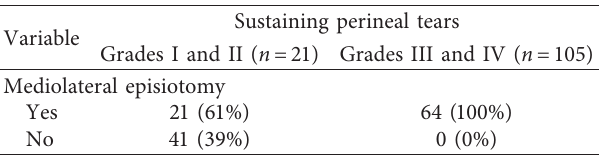
Table 3: Percentage of patients who underwent mediolateral episiotomy and sustained a degree of perineal tears.